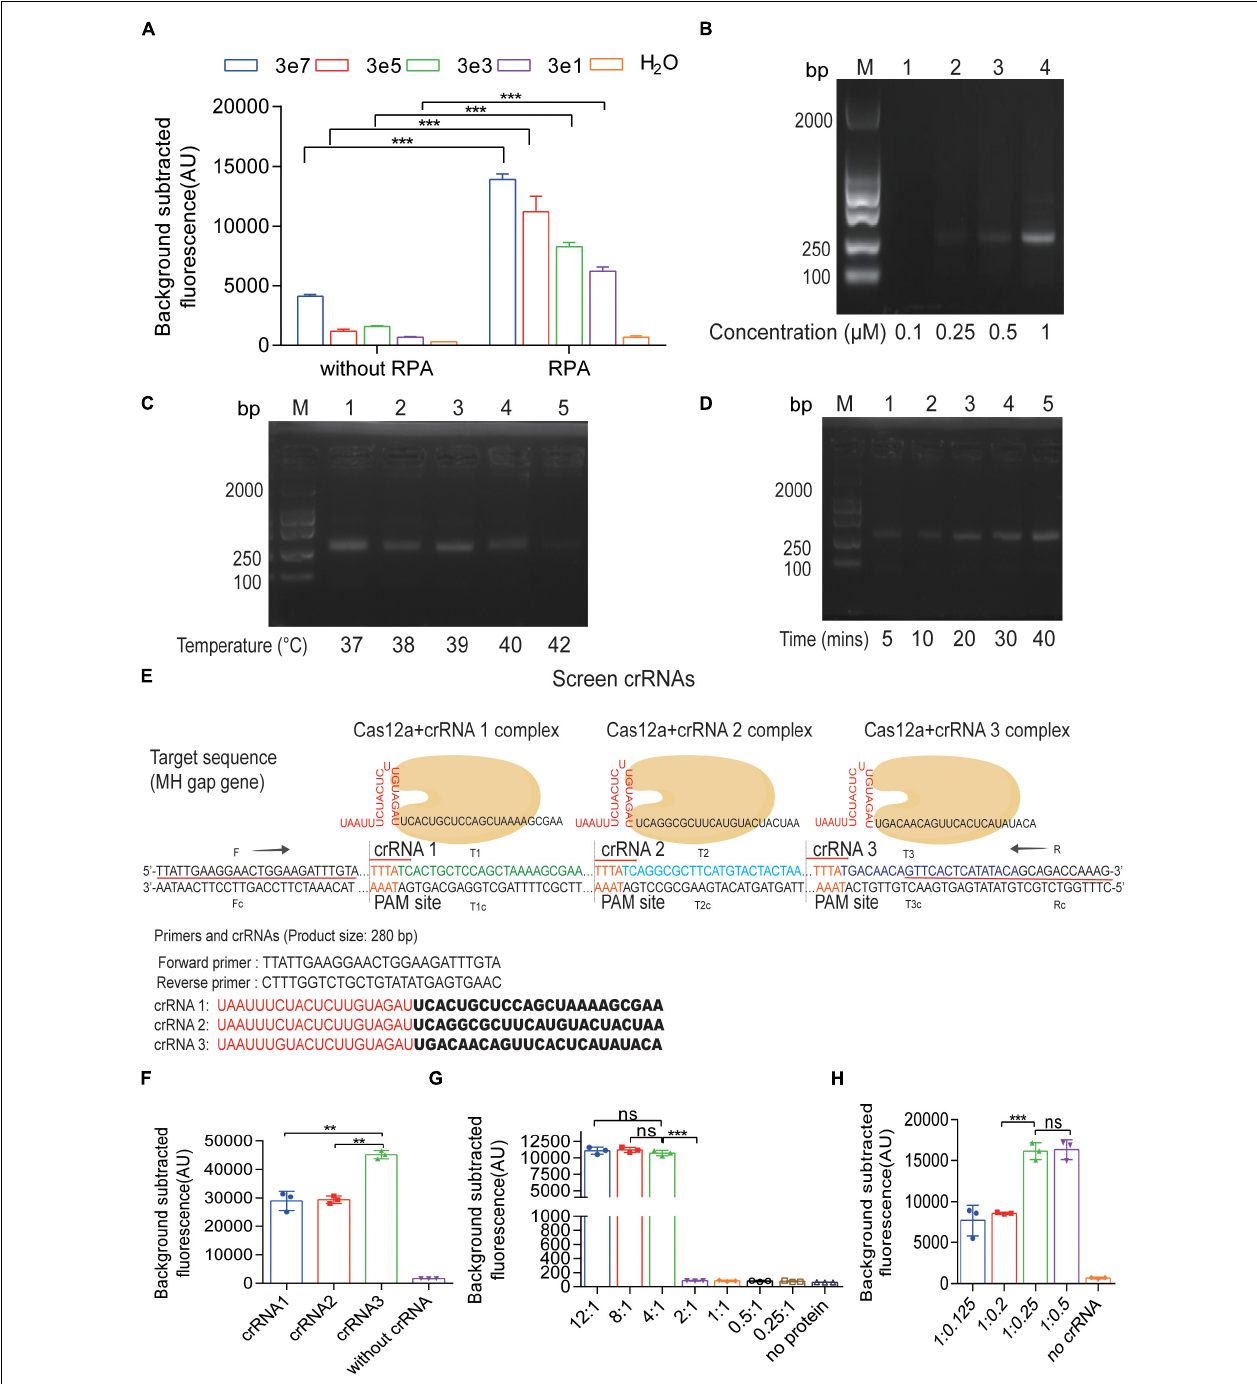
FIGURE 3 | Optimization of the CRISPR-Cas12a fluorescent assay. (A) Detection of fluorescent signals from serial 10-fold dilutions of the pMD19-T-MH gap by CRISPR-Cas12a fluorescent assay with or without RPA amplification. (B) Agarose gel electrophoresis results of PRA products amplified by different concentrations of primers. (C) Agarose gel electrophoresis results of PRA products amplified by different temperature. (D) Agarose gel electrophoresis results of PRA products amplified by different time. (E) The sequences of RPA primers and three crRNAs for the gap gene of M. hominis . (F) Fluorescent results of the pMD19-T-MH gap detected by the RPA-Cas12a-Fluo assay with crRNA1, crRNA2, and crRNA3. (G) Fluorescent results of the pMD19-T-MH gap detected by the RPA-Cas12a-Fluo assay with a different Cas12a:crRNA ratio. The ratio of 4:1 reached the highest fluorescent value. (H) Fluorescent results of the pMD19-T-MH gap detected by the RPA-Cas12a-Fluo assay with a different Cas12a:crRNA ratio. The ratio of 1:0.25 reached the highest fluorescent value. The data are presented as the mean ± SD from three independent experiments. ** p < 0.01; *** p < 0.001; ns, p > 0.05. Abbreviations: MH, M. hominis ; RPA, recombinase polymerase amplification; bp, base pair; M, marker; gap, glyceraldehyde-3-phosphate dehydrogenase.